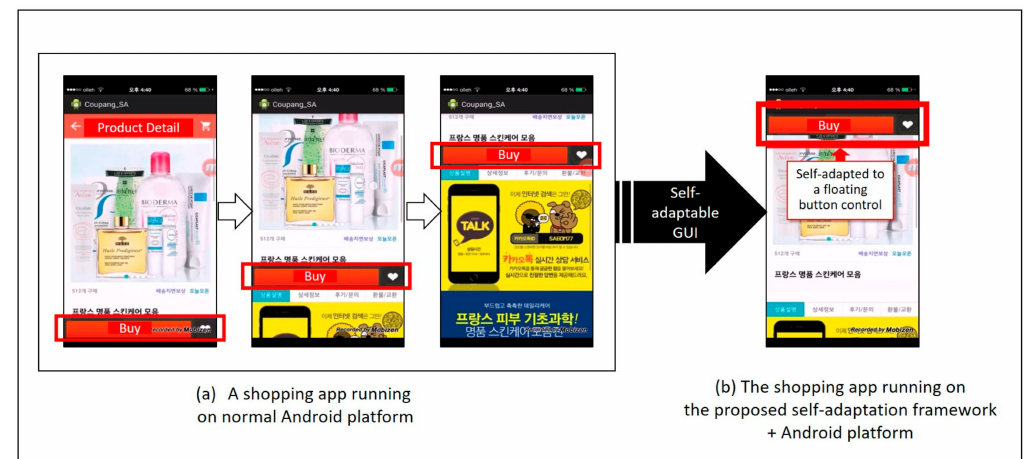
Figure 2. Comparison of the same mobile app ( a ) on a normal Android platform; and ( b ) on the proposed self-adaptation